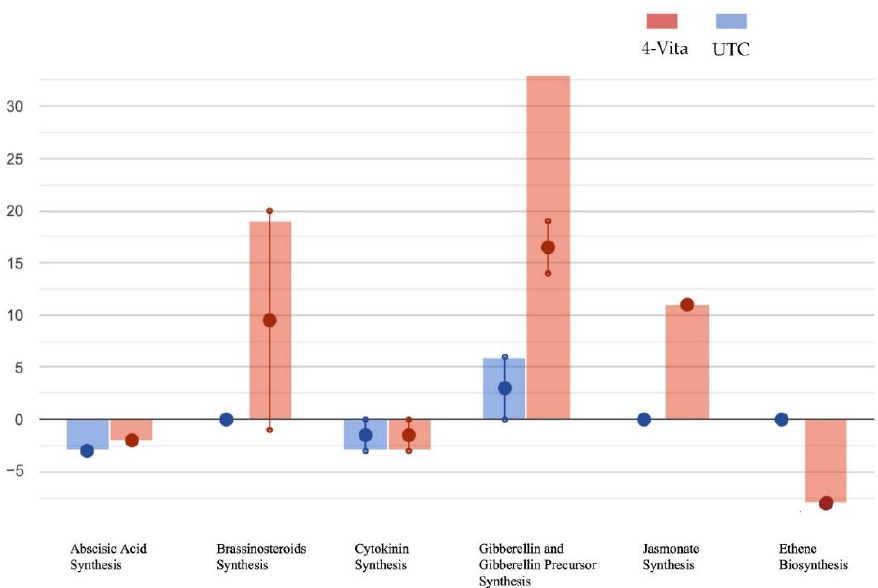
Figure 7. Phytohormones being modulated in tomato leaves following the treatments with 4-Vita conditions, compared to untreated control (UTC). The x -axis represents each set of metabolic subcategories, while the y -axis corresponds to the accumulative Log fold change (Log FC). The large dots represent the average (mean) of all Log FCs in the class, whereas small dots represent individual Log FC values. Abbreviations: Syn: synthesis.